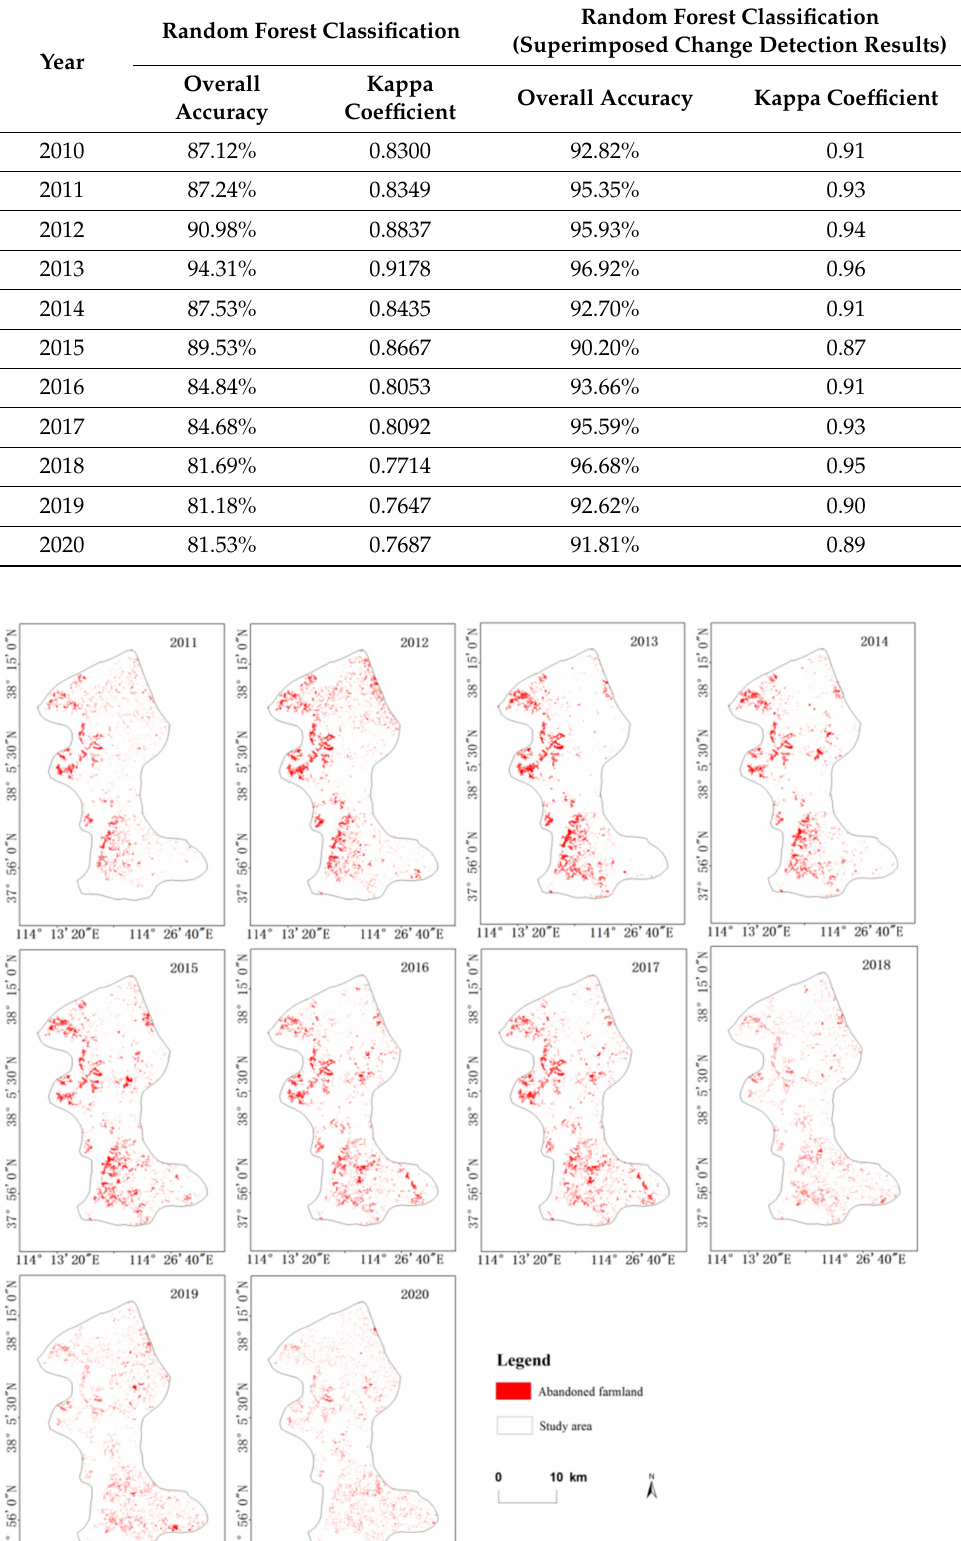
Table 2. Classification accuracy.